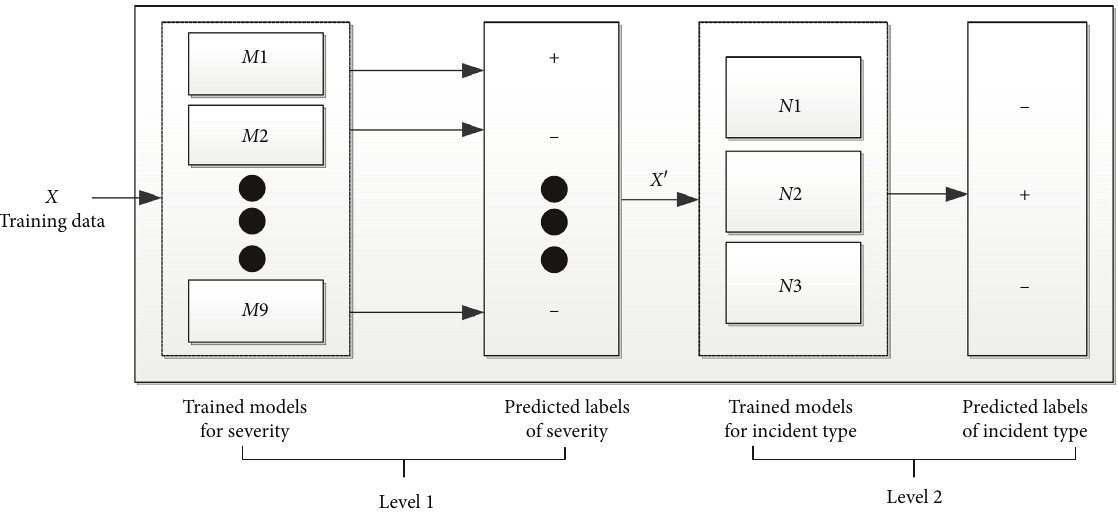
Figure 2: Block diagram of proposed classification